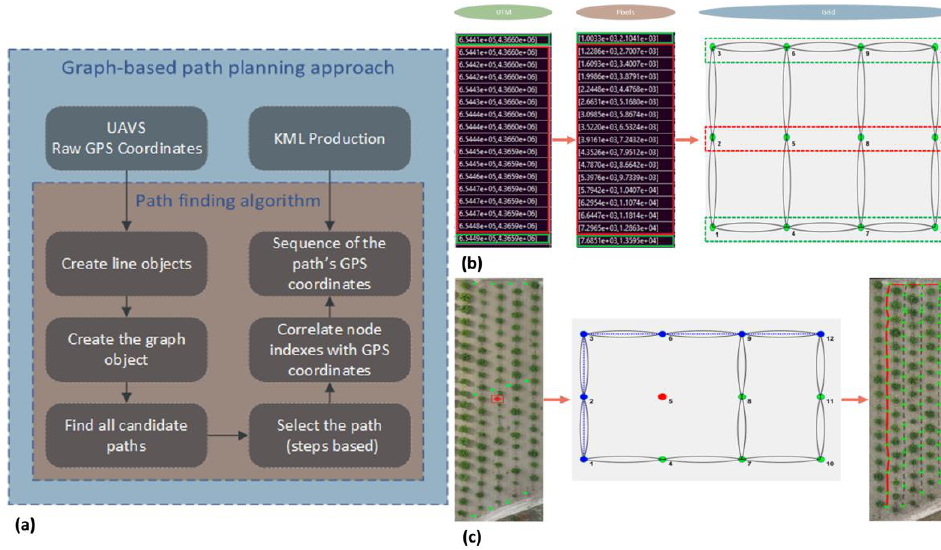
Figure 11. Path planning technique: ( a ) structure and information/data flow; ( b ) UTM coordinates to the topological map; and ( c ) path generation.